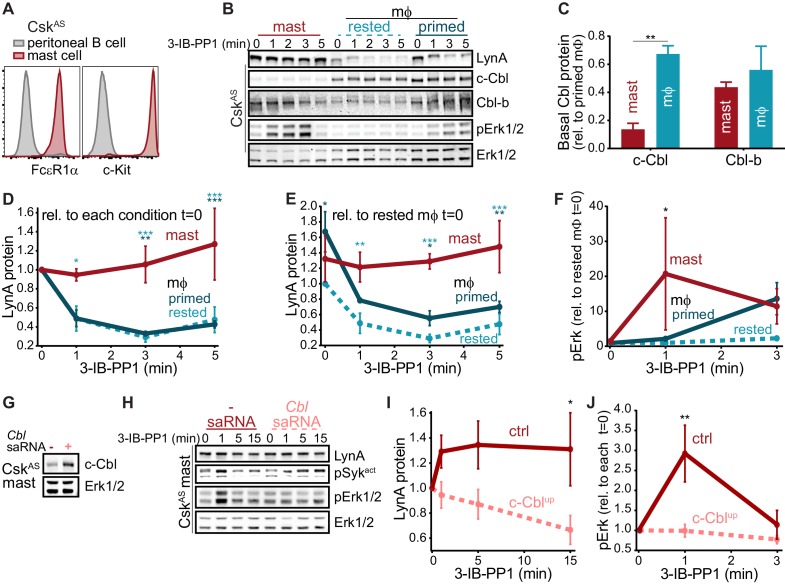
Differential expression of c-Cbl tunes LynA protein levels and SFK-mediated downstream signaling in macrophages and mast cells.(A) Flow cytometry showing surface expression of the mast-cell markers FcεR1α and c-Kit (CD117) in CskAS bone-marrow-derived mast cells (red) compared to peritoneal B cells (gray). (B) Immunoblots of CskAS mast cells and BMDMs (mϕ) after resting or IFN-γ priming, showing the levels of LynA, c-Cbl, Cbl-b, and pErk1/2 during 3-IB-PP1 treatment; total Erk1/2 is shown as a loading control. (C–F) Quantification of c-Cbl, Cbl-b, LynA, and pErk in mast cells (red), IFN-γ-primed mϕs (dark teal), and rested mϕs (light teal). (C) Quantification of steady-state c-Cbl and Cbl-b protein in mast cells and rested mϕs, corrected for total protein content (TPS) and reported relative to levels in primed mϕs. SEM, n = 3. Sig. from one-way ANOVA with Sidak’s multiple comparison test: [mast vs. rested mϕs] **p=0.0035. Others pairs ns. (D–E) Quantification of LynA in mast cells and mϕs during 3-IB-PP1 treatment, corrected for total protein content (TPS) and reported relative to the steady-state level of LynA in each cell type (D) or relative to the steady-state level of LynA in rested mϕs (E). SEM, n = 3 for mast cells and primed mϕs, n = 4 for rested mϕs. Sig. from ANOVA2-Tukey: [mast vs. rested mϕs, light teal asterisks], [mast vs. primed mϕs, dark teal asterisks]; ***p=0.0004–0.0008, **p=0.0025–0.0088, * P=0.0134–0.0466. Other pairs ns. (F) Quantification of pErk1/2 induction during 3-IB-PP1 treatment, corrected for total Erk1/2 expression and reported relative to the steady-state level of pErk1/2 in rested mϕs. SEM, n = 3 for mast cells, n = 4 for primed mϕs, n = 5 for rested mϕs. Sig. from ANOVA2-Sidak: [mast vs. rested mϕs, asterisk]; *p=0.0330. Other pairs ns. (G) Immunoblots showing steady-state expression of c-Cbl in CskAS mast cells transfected in the presence or absence of Cbl-specific saRNA; Erk1/2 is shown as a loading control. (H) Immunoblots showing levels of LynA protein, pSyk, and pErk1/2 during 3-IB-PP1 treatment of Cbl-saRNA-transfected or mock-transfected mast cells. (I–J) Quantification of LynA and pErk in mast cells with (pink) and without (red) saRNA-induced upregulation of c-Cbl protein. SEM, n = 3. (I) Quantification of LynA protein during 3-IB-PP1 treatment, corrected for total protein content (TPS) and reported relative to the steady-state level for each transfection condition. Sig. from mixed-effects ANOVA analysis: *p=0.0229. (J) Quantification of pErk1/2 induction during 3-IB-PP1 treatment in saRNA-treated and mock-treated mast cells, corrected for total Erk1/2 expression and reported relative to the steady-state level for each condition. SEM, n = 3 for mast cells. Sig. from ANOVA2-Sidak: **p=0.0045. Refer to Figure 9—source data 1.10.7554/eLife.46043.041Figure 9—source data 1.Comparison of mast cells and macrophages.